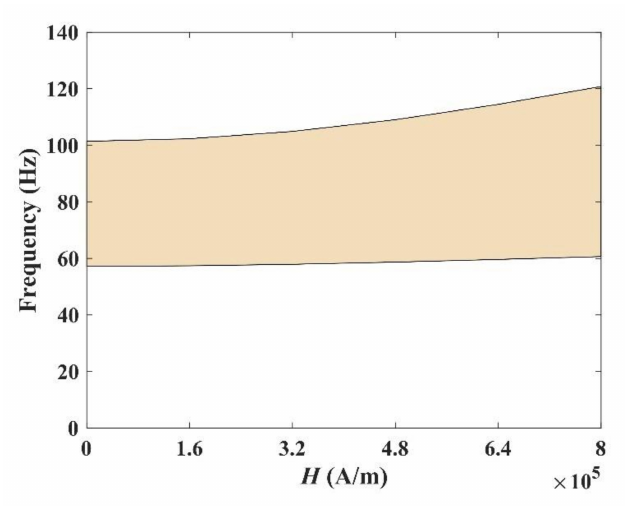
Figure 14. The influence of magnetic field intensity H on the band gap.